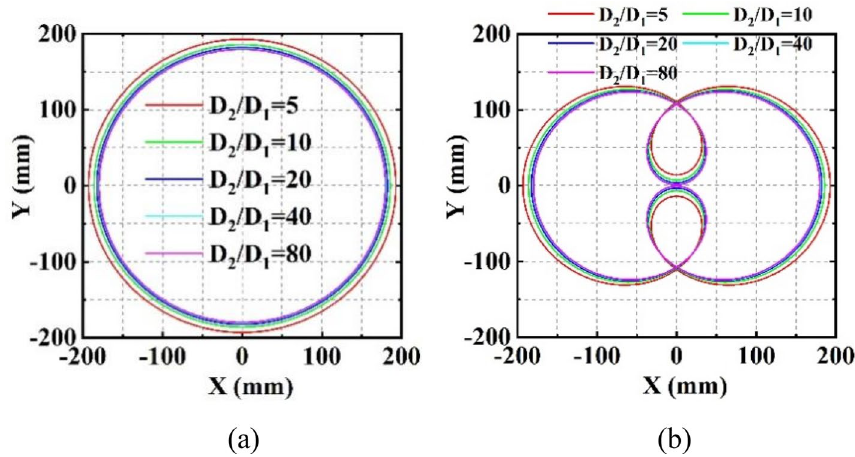
Figure 5. Beam trajectories with different D 2 / D 1 ratios ( a ) ω 1 = ω 2 ( b ) ω 1 = 3 ω 2 , where ω 1 and ω 2 are the rotationally angular speed of the two metalens 12,45